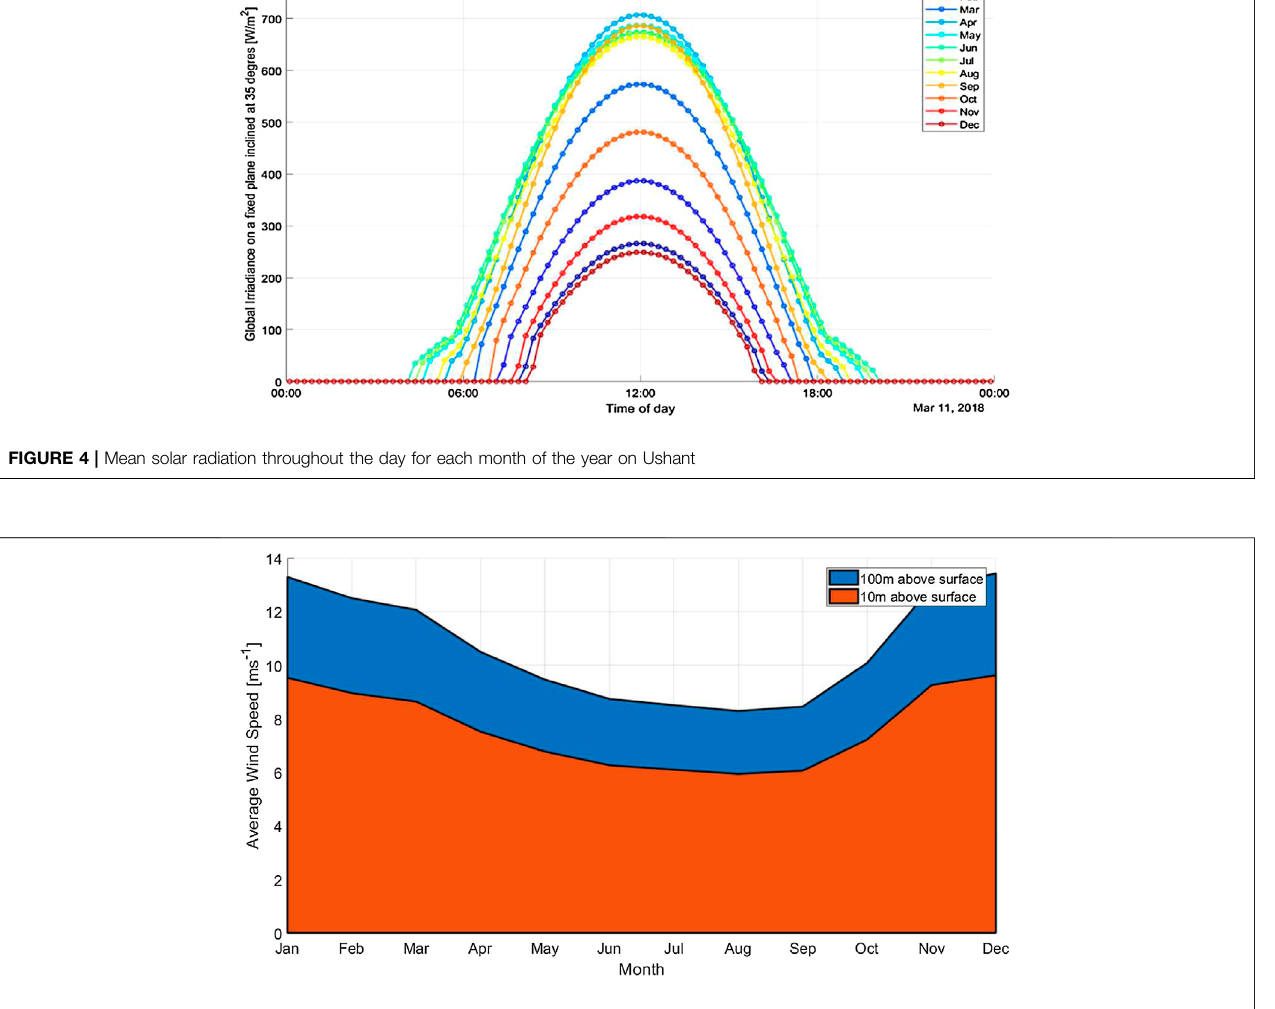
FIGURE 5 | Average monthly wind speed at 10 m and 100 m above sea